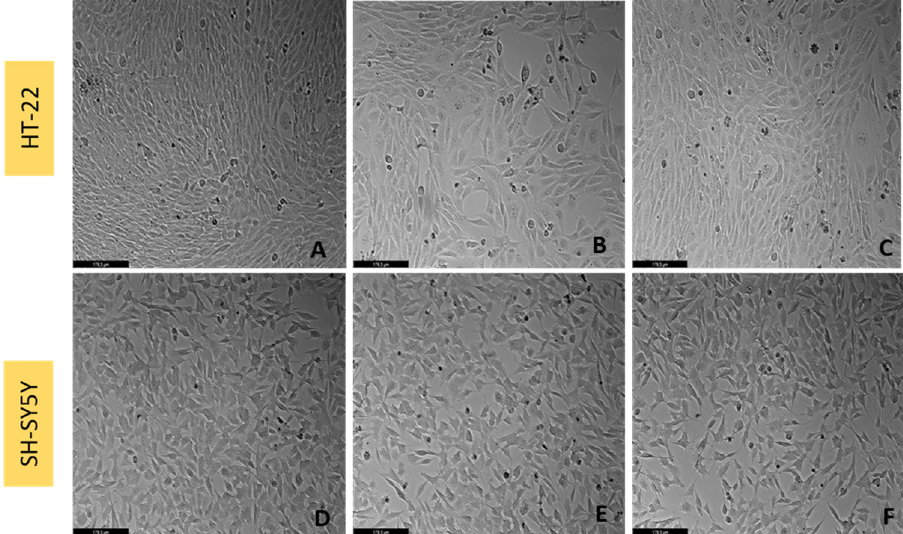
Figure 13. Effect of 48 h-incubation of ( A ) 132 μ M of H 2 O 2 and ( B ) 105 μ M of H 2 O 2, in combination with 0.1 nM–100 μ M of L-tryptophan, determined by MTT methodology. The results represent the mean ± SEM of three independent experiments, expressed as the percentage of the vehicle (100%). Statistically significant **** p < 0.0001 vs. vehicle.